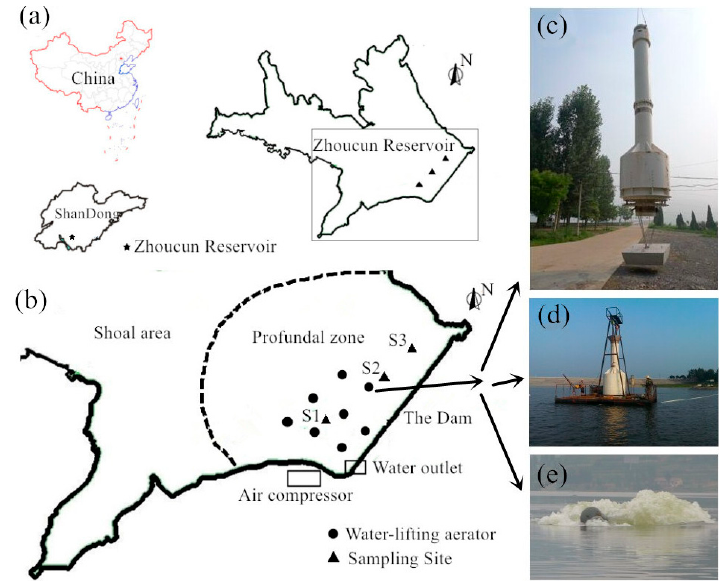
Figure 1. Bathymetric map of the Zhoucun Reservoir with the location of the sampling site ( a ); the layout of the WLAs in the reservoir ( b ) and WLA photos during construction and operation ( c – e ) (( c ) appearance of WLA; ( d ) work platform on the water; and ( e ) surge from the WLA).